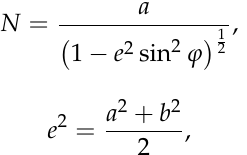
where a denotes the long radius of the ellipsoid; b is the short radius of the ellipsoid. The rectangular coordinates of each vertex of the detection area 1 (see Table 2) can be obtained by Equations (1). Table 2. Rectangular coordinate of the vertices of detection area